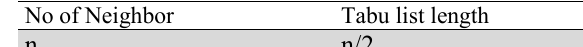
The MSTS parameters tuning results No of